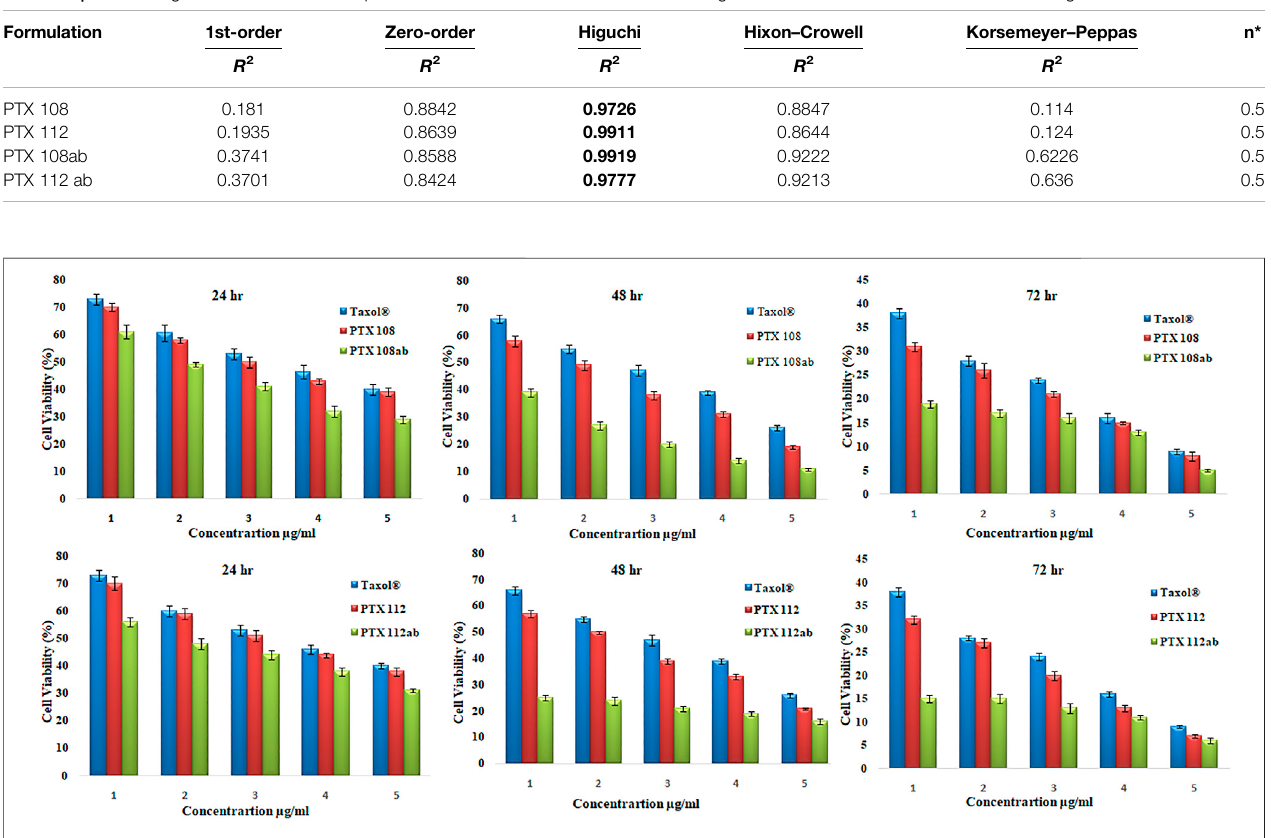
Frontiers in Pharmacology |